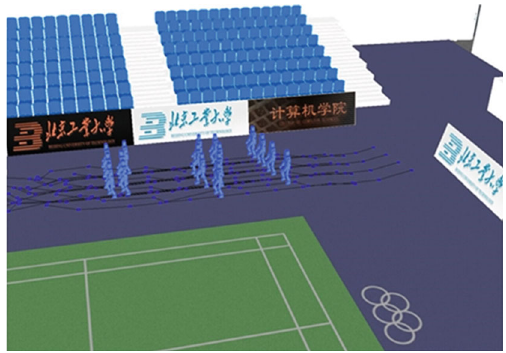
Figure 18: The editing result when characters pass the center of stadium.